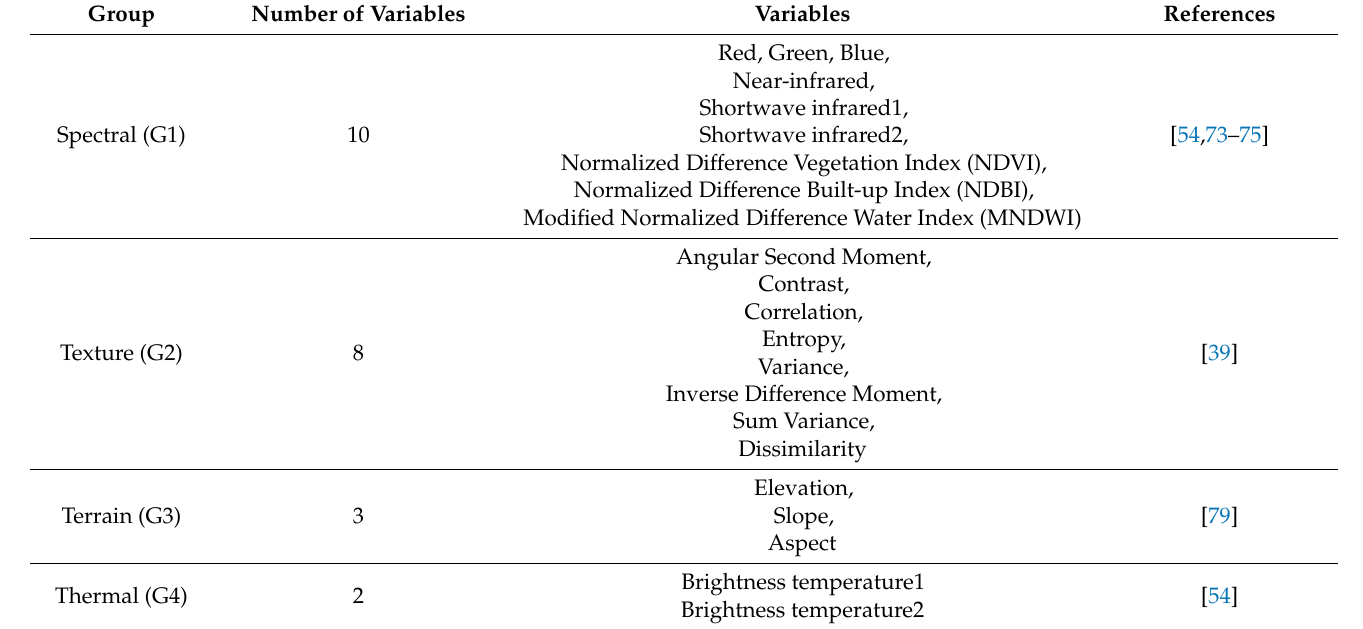
Table 1. The variables from G1, G2, G3, and G4 were used to classify the PV power plants in the study area. Group Number of Variables